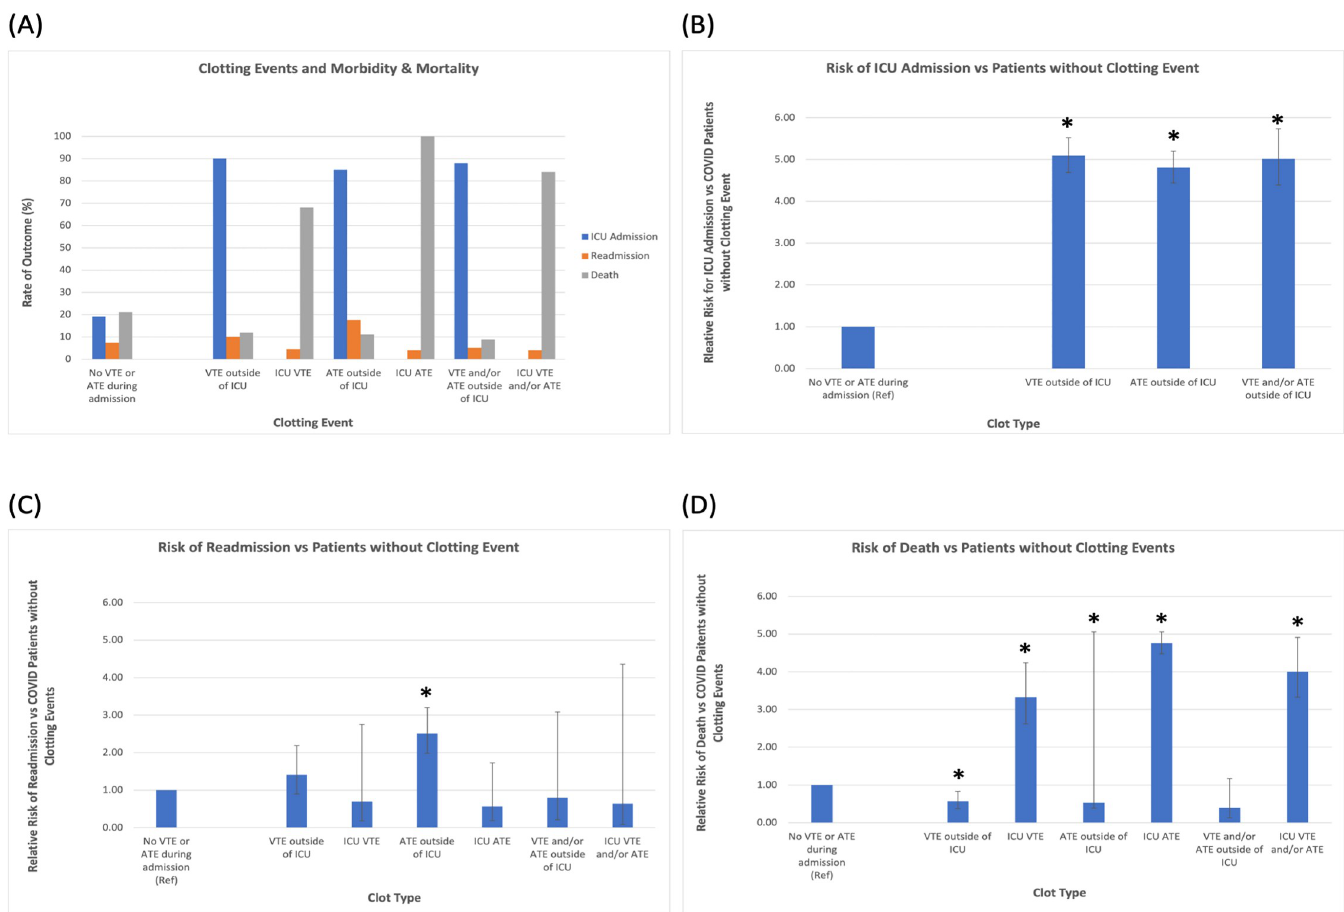
Fig 2. Impact of clotting events on risk of ICU admission, re-admission, and death. (A) Rates of ICU admission, readmission to the hospital after discharge, and death for hospitalized COVID-19 patients with and without venous or arterial clots during their initial COVID admission. (B) COVID-19 patients who developed venous and/ or arterial clots during admission were significantly more likely to require escalation to ICU care than their counterparts who did have clotting events. (C) COVID-19 patients who developed arterial clots outside of the ICU were significantly more likely to be readmitted to the hospital. While the risks of readmission for other COVID- 19 patients with thrombotic events seem lower, this is likely skewed by the fact that many of those patients did not survive to initial hospital discharge, as illustrated by (D) which shows the significantly higher risk of death among COVID-19 with clotting events than those without. In the small number of patients with clots who were not admitted to the ICU, mortality was less than in the general hospital population; however, this is probably biased by the large number of palliative and hospice care patients who passed away on the floor and would not have been admitted to the ICU. Bars represent 95% confidence intervals. � p-value statistically significant at less than 0.05 level. See Table 3 for RR values. (VT/VTE = Venous Thrombosis/Venous Thromboembolism; AT/ATE = Arterial Thrombosis/Arterial Thromboembolism; RR = Relative Risk).